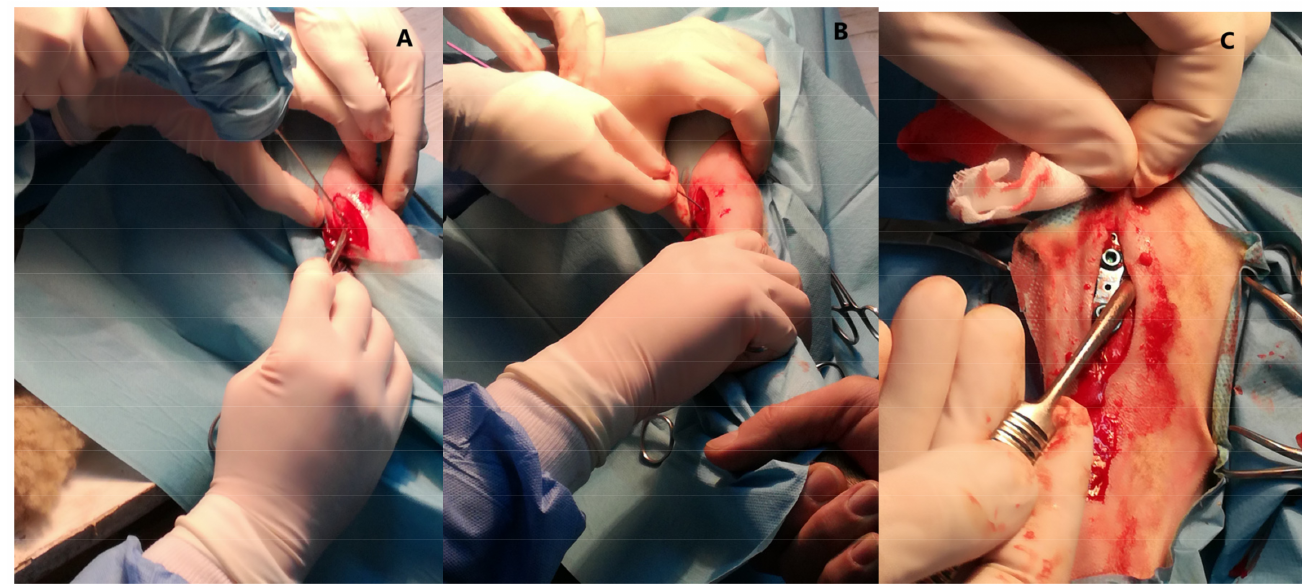
Figure 11. A clinical photographs of implant insertion on the ovine tibia: ( A ) dissection of soft tissue and ( B ) periosteum. ( C ) implants installed in the right